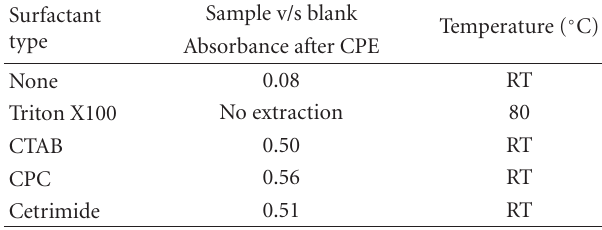
Figure 5: E ff ect of pH. Table 1: E ff ect of surfactant.